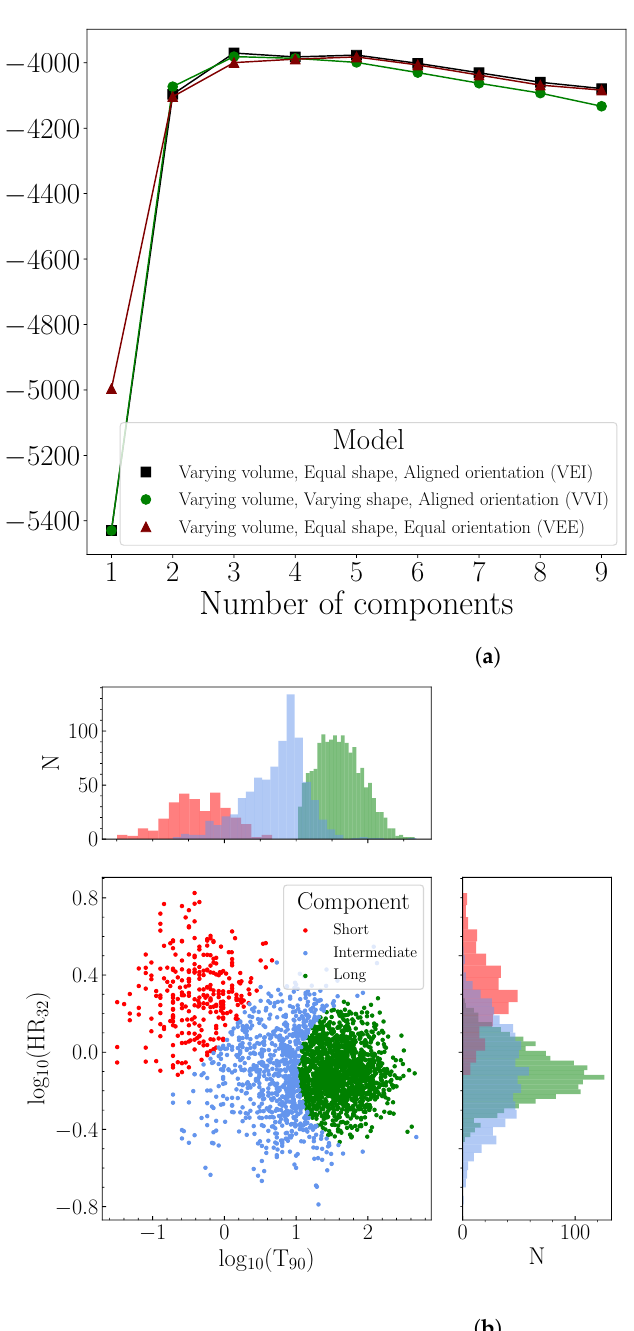
Figure 5. ( a ) BIC values of the top three MCLUST models fit to the Fermi /GBM sample and ( b ) the re- sulting duration-hardness plane for the best-fit three-component model